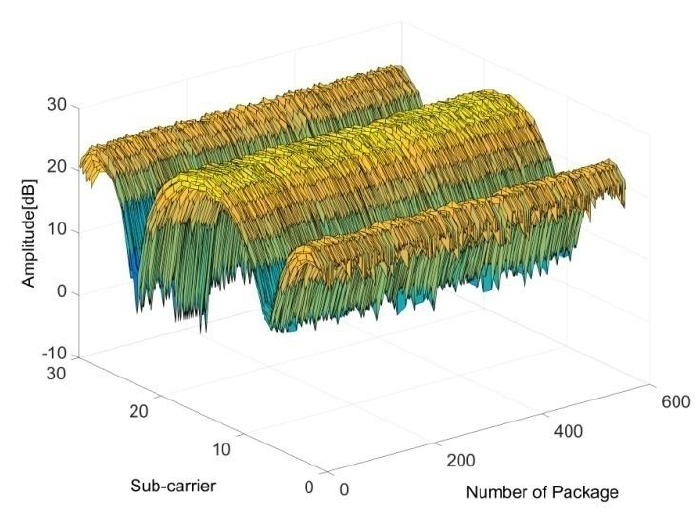
Figure 14. Raw WCI for abnormal breathing.